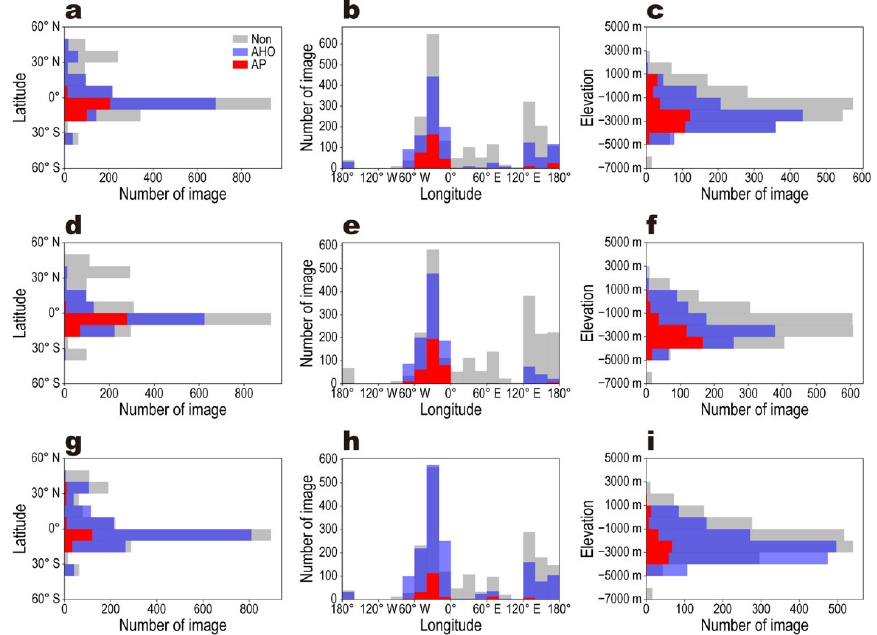
Figure 8. Histograms of numbers of recognized AHO chaos blocks (blue), AP chaos blocks (red), and non-chaos features (gray) as functions of latitude ( a , d , g ), longitude ( b , e , h ), and elevation ( c , f , i ) on Mars for the different classifiers; CTX ( a – c ), THEMIS ( d – f ), and MOLA ( g – i ).